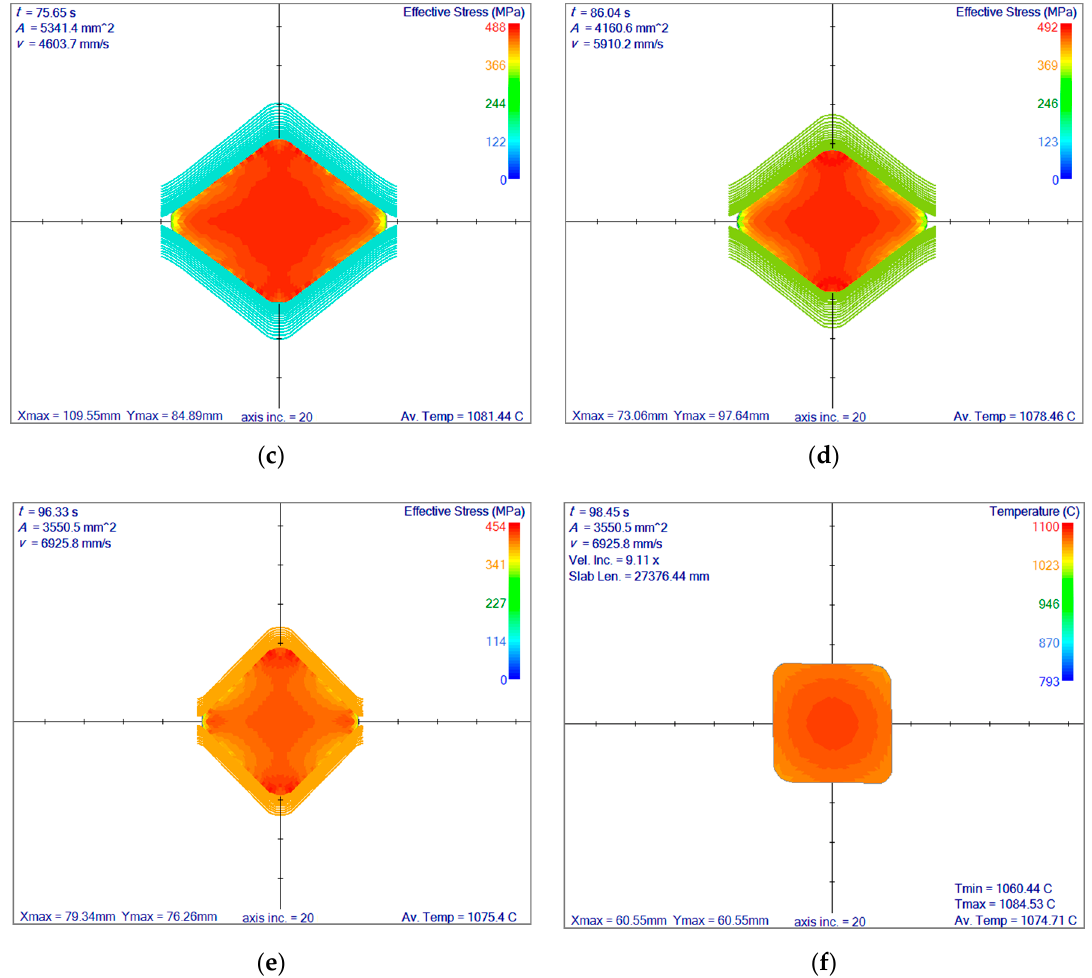
Figure 12. Second part of the reversing rolling mill simulation, where the roll diameter used is 650 mm before and after the billet is rotated 45 deg. In between the passes, it is rotated 90 deg. Results are shown in terms of effective stress filed. ( a ) After sixth pass, ( b ) after seventh pass, ( c ) after eighth pass, ( d ) after ninth pass, ( e ) after tenth pass, ( f ) final shape with temperature field.